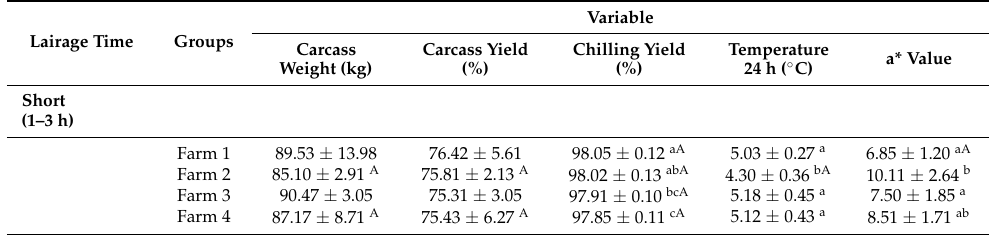
Table 7. Effect of different total biosecurity scores and lairage time on carcass and meat quality